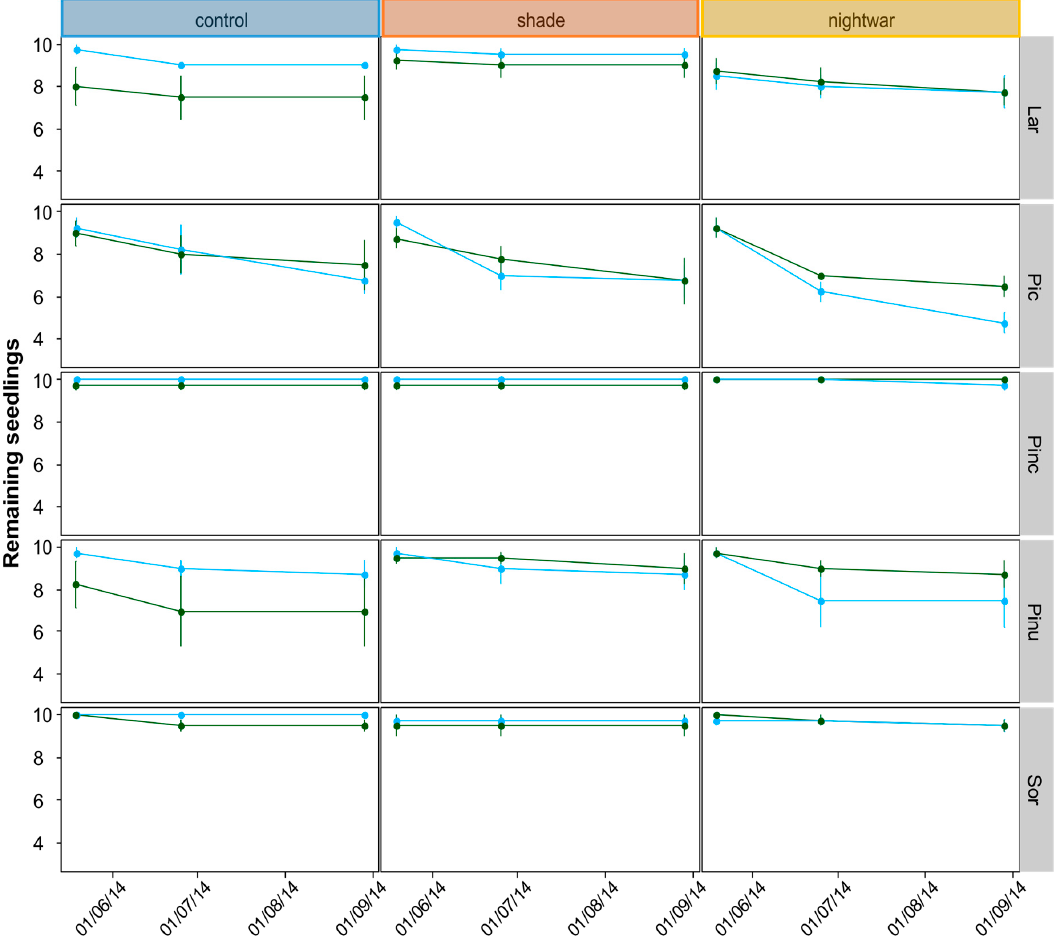
Figure A4 . Tree seedling remaining through time after having been planted in autumn 2013 near the treeline in the French Alps. Species: Lar = Larix decidua , Pic = Picea abies , Pinc = Pinus cembra, Pinu = Pinus uncinata, Sor = Sorbus aucuparia . Line colors represent snow treatments: early (dark green) and late (blue). Columns show different sky-exposure treatments: control (no roof), shade (shade roof during the day), and nightwar = night warming (shade roof during the night). A GLM of final mortality indicated that for early-emerging seedlings, shade caused lowered mortality overall, while species did not differ. However, a pair-wise comparison of survival curves showed that there were no significant differences between treatments in any of the species. Measurement dates: 19 May, 25 June, 29 August 2014.